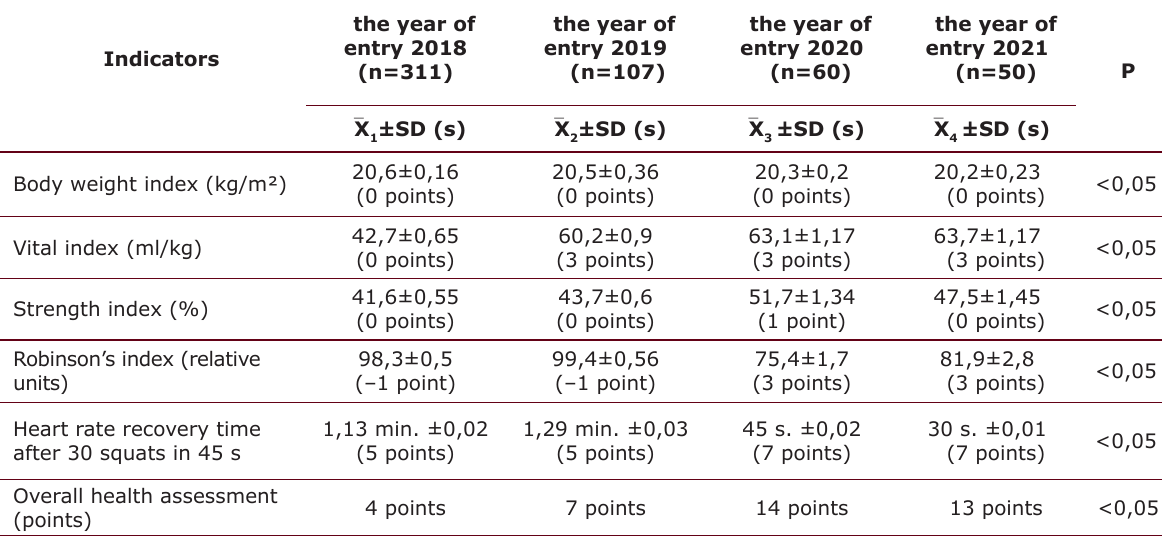
Table 2. Express assessment of the level of somatic health according to the method of